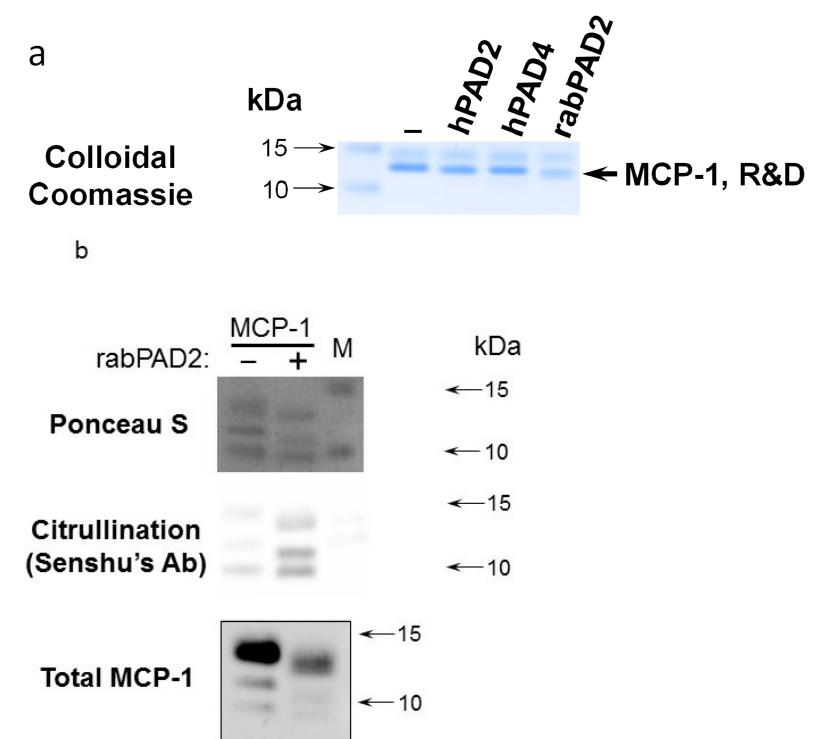
Figure 1. In vitro citrullination of bacterially produced chemokines leads to their partial degradation. ( a ) Colloidal Coomassie stained SDS-PAGE analysis of the MCP-1/CCL2 products of in vitro citrullination . In vitro citrullination of commercially available recombinant MCP-1/CCL2 and self-made bacterially produced MCP-1/CCL2 performed with recombinant human PAD2 and PAD4 or rabbit PAD2, respectively. Colloidal Coomassie stained MCP-1 bands are shown while recombinant humanPAD2/4 or rabbit PAD2 (Sigma Aldrich/Merck, Waltham, MA, USA) were added to reactions into the quantities below the Colloidal Coomassie sensitivity limits and cannot be visualized. ( b ) Immunoblot analysis of bacterially produced MCP-1/CCL2 upon an in vitro citrullination reaction. Self-made full-length bacterially produced MCP-1/CCL2 was citrullinated in vitro with rabbit PAD2 and resolved on SDS-PAGE, stained with Ponceau S. detection of total MCP-1/CCL2 and modified citrullines with Senshu’s antibody that recognizes that modified citrullines were made according to Senshu’s protocol [20]. Results shown are a representative of three or more repetitive experiments. Therefore, the 6xHis-tagged version of MCP-1/CCL2 chemokine cDNA was further re-cloned into mammalian pcDEF expression vector, in an order to confer a high expres- sion level of MCP-1/CCL2 chemokine. The mammalian expression vector was transfected into HEK 293T cells using a PEI reagent. The cellular lysate with glycosylated mature MCP-1/CCL2 was collected and purified with ProBond nickel beads and gradually eluted with 50, 100, 150 and 200 mM imidazole. Both the pre-protein and its mature version con- tain four arginine residues at the positions corresponding to 18, 24, 29 and 30 in the mature protein (Figure 2a). The diagnostic 1-Da mass shift occurring upon citrullination of MCP- 1/CCL2, was identified by mass spectrometry at the peptide that contains Arg-18 of the mature protein (Figure 2b). In spite of the presence of three more arginine residues at the positions 24, 29 and 30 within the mature MCP-1 protein (Figure 2a), we failed to detect citrullination at those residues using a mass-spectrometry.